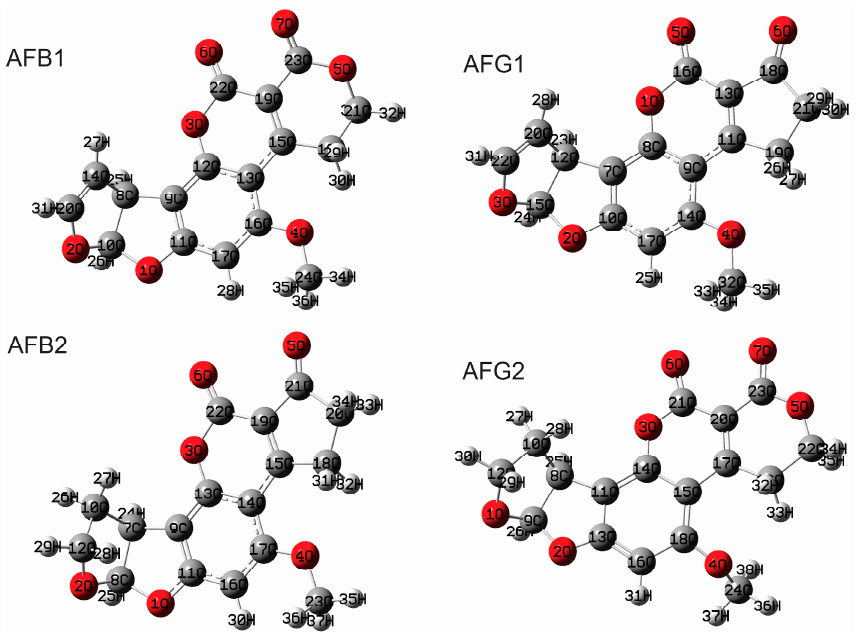
Figure 2. Optimized molecular structure of aflatoxins calculated with B3LYP/6-311G(d,p) in the gas phase. Table 1. Geometrical parameters for AFB1 calculated in the gas and solvent phases using the IEFPCM solvation model and the X-ray diffraction data reported for the same compound.